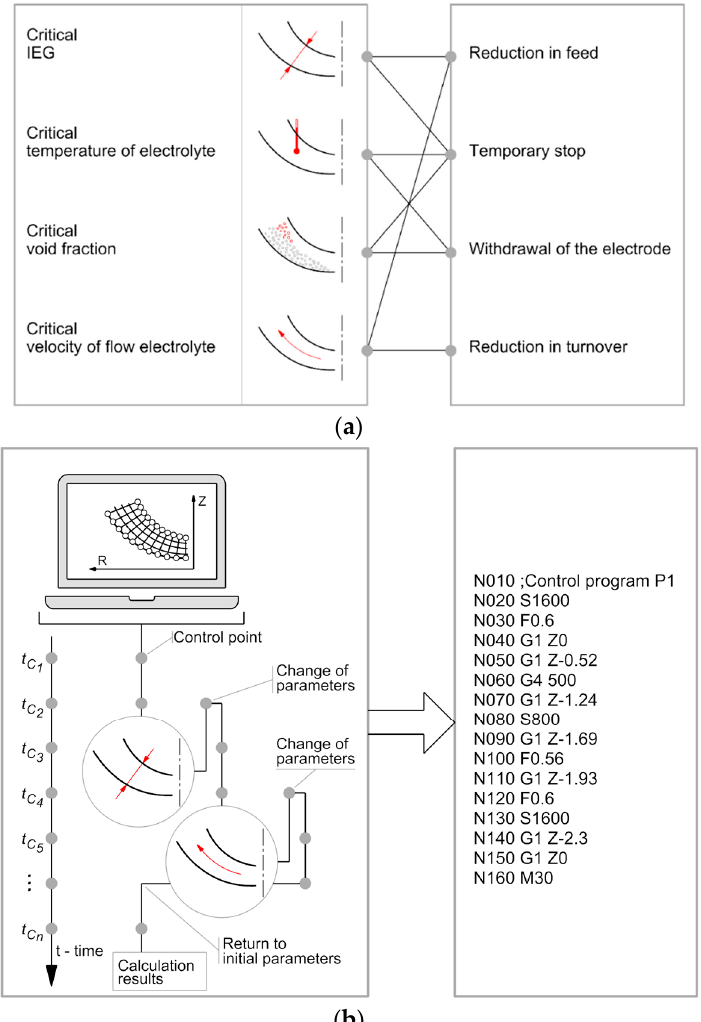
Figure 5. Adaptive control diagram: ( a ) the critical states and device response identification, ( b ) machining simulation and control program.